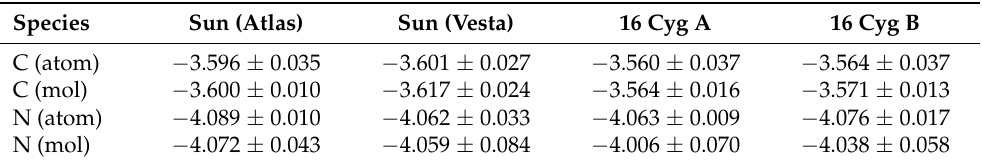
Figure 3. Comparison between the observations and spectrum synthesis in the regions of the C 2 Swan bandhead ( left panel ) and CN molecular lines ( right panel ). The observations are shown by black dots, the synthetic spectra calculated with the determined atmospheric parameters and abundances are shown by the solid red line. The fitted intervals are marked by colored bands. The blue dashed lines in the left panel demonstrate theoretical calculations without the C 2 molecular lines. Table 2. Carbon and nitrogen abundances in the sun and in the binary system 16 Cyg derived from the analysis of the atomic and molecular